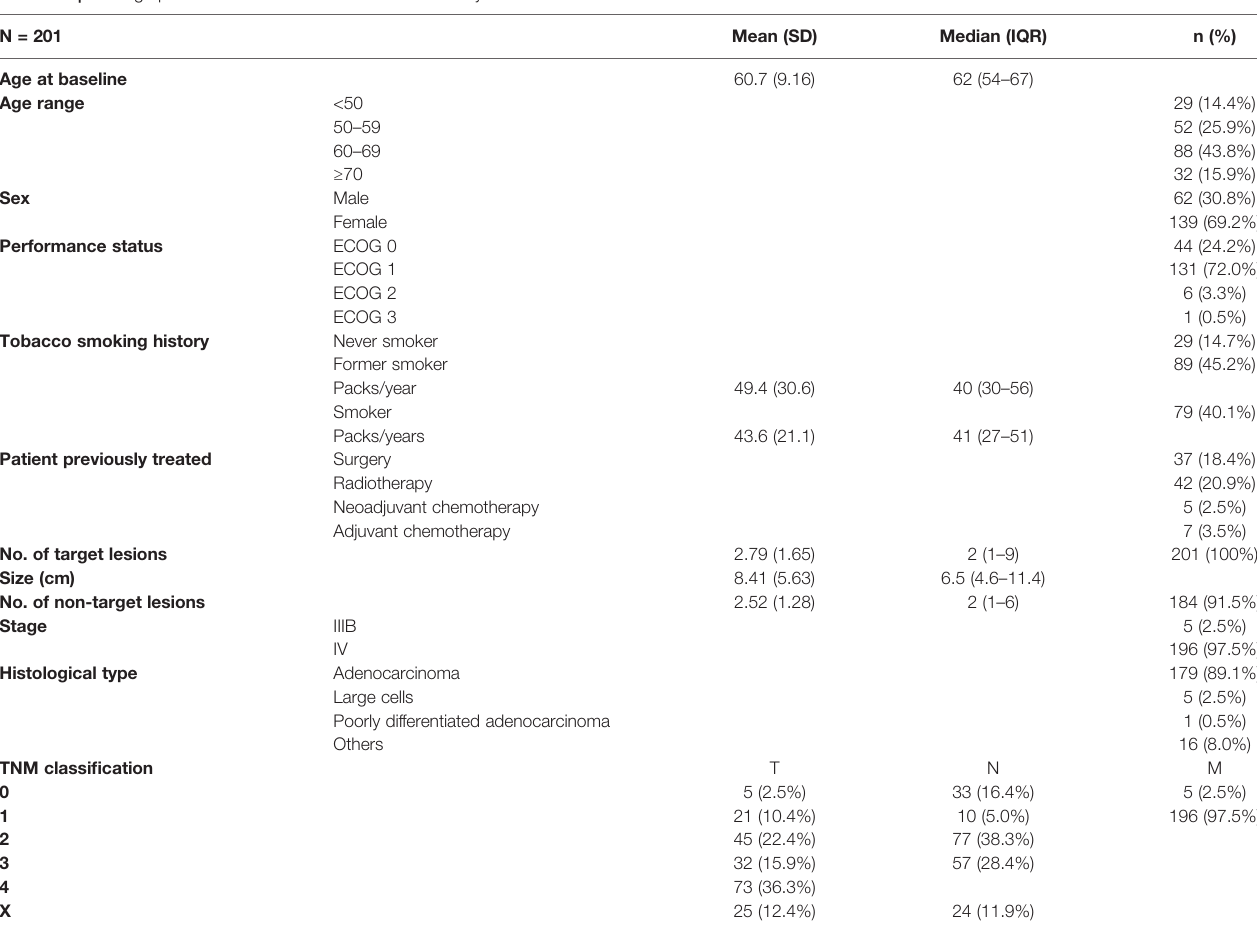
TABLE 1 | Demographic and clinical characteristics of the study